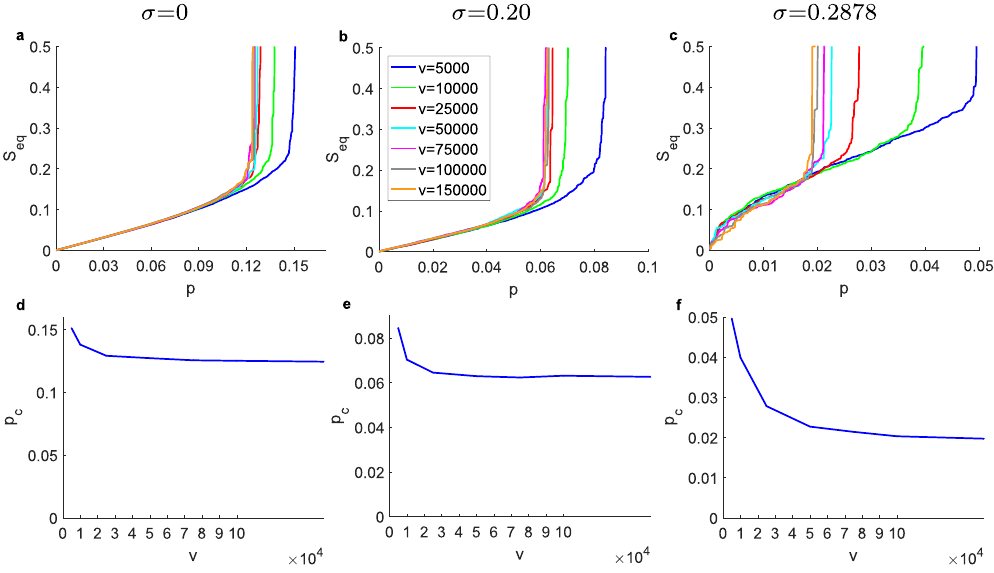
Figure 7. Impact of the number of randomizations v on the performance of the GPI strategy for s = 0.0025 for desired cascade S goal = 0.5, for ER graphs with N = 10,000, 〈 k 〉 = 10, ρ = 0. ( a – c ) Cascade S eq vs. the initiator fraction p for σ = 0, 0.2, 0.2887, respectively (for one realization). ( e – g ) Initiator fraction p c required for desired cascade S goal = 0.5 vs. randomizations v for σ = 0, 0.2, 0.2887, respectively (for one